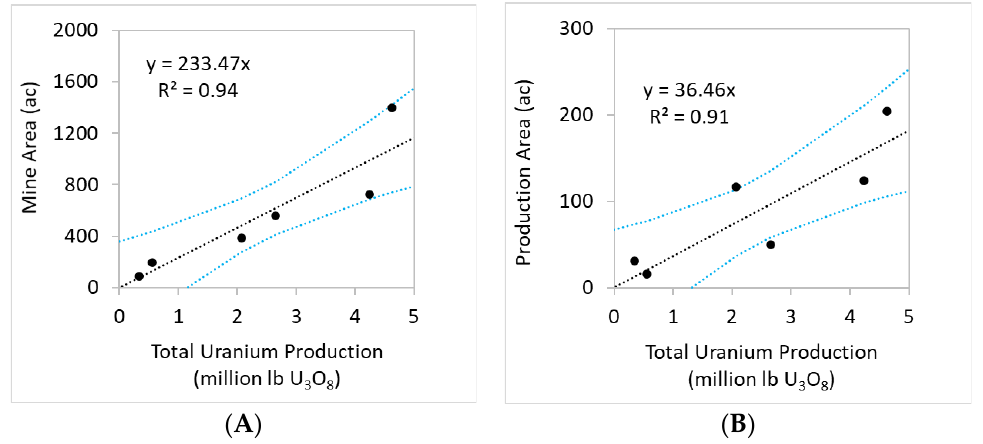
Figure 6. ( A ) Mine area and ( B ) production area as a function of uranium produced (as lb U 3 O 8 ) for the six ISR operations listed in Table A1. Compiled data used to construct these graphs as well as associated references are publicly available online [18]. Note: ac = acres. Black line is the linear trend line and blue lines are the 95 percent confidence intervals.